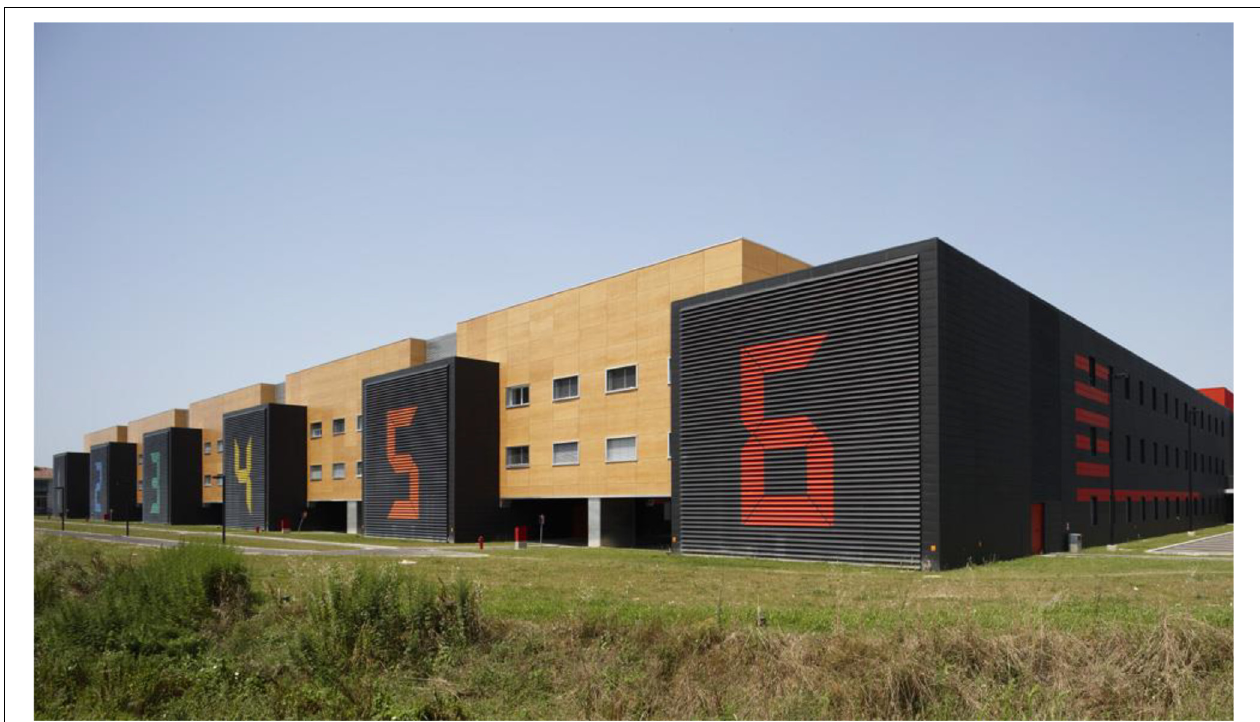
FIGURE 1 | The six buildings of the “I Praticelli” university residence hall with number and color